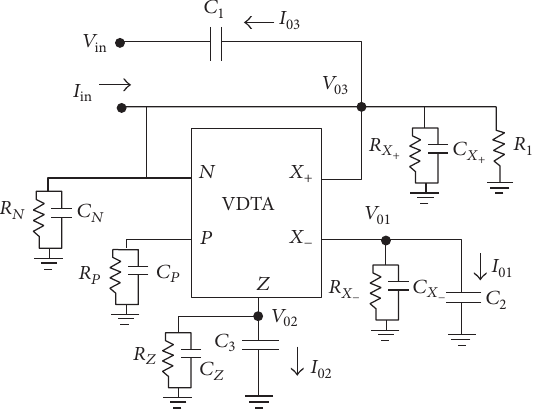
Figure 5: Nonideal filter